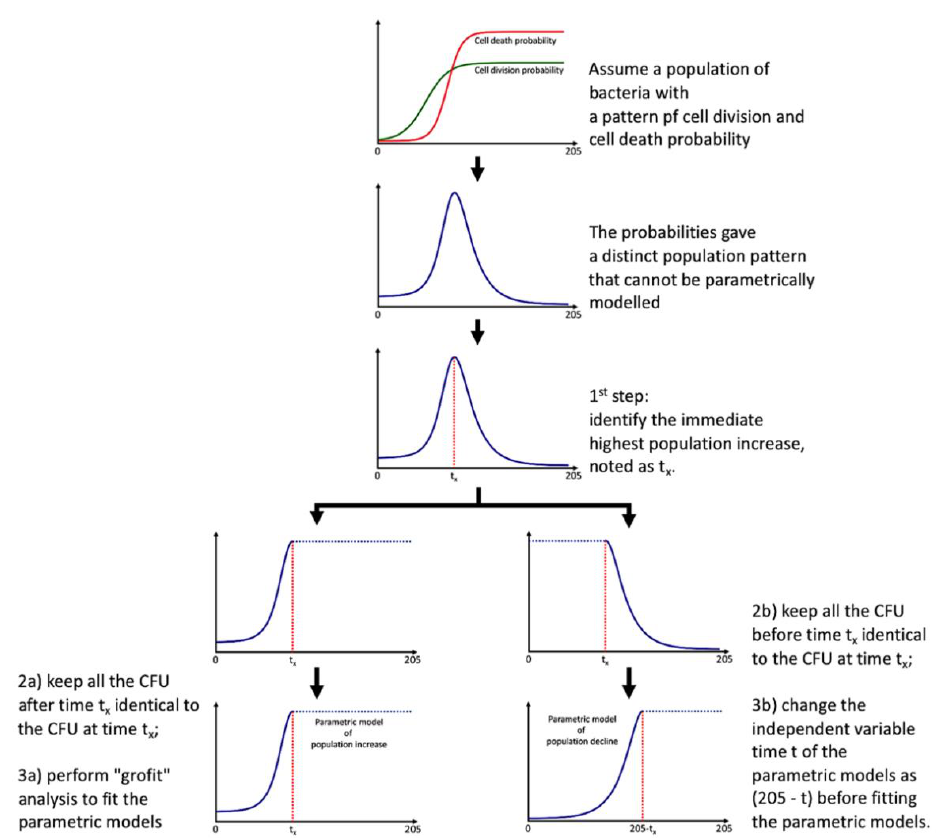
Figure 2. Parametric modeling of total probiotic population pattern with a decline phase. The use of logistic and / or Gompertz functions cannot capture the microbial community growth pattern due to the presence of a decline phase. Instead of employing other complex models that include the decline phase, we insisted on the use of either the logistic and / or Gompertz functions with extra steps, composed of the identification of tipping point tx, followed by the modeling of the logistic and Gompertz functions separately on the exponential increase part and the decline phase part after mirroring. Still, all these parameters obtained possess biological meanings. Commensal bifidobacteria are enumerated as total